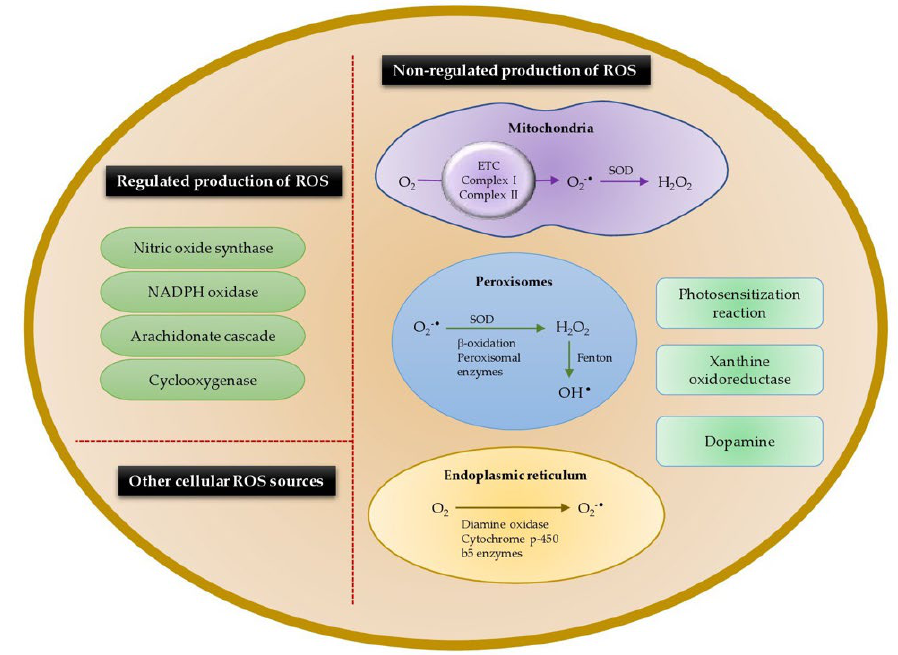
Figure 5. Sources of reactive oxygen species and free radicals in biological systems. The generation of ROS in the biological systems can be due to the non-regulated production of ROS, regulated production of ROS, and other cellular ROS sources.